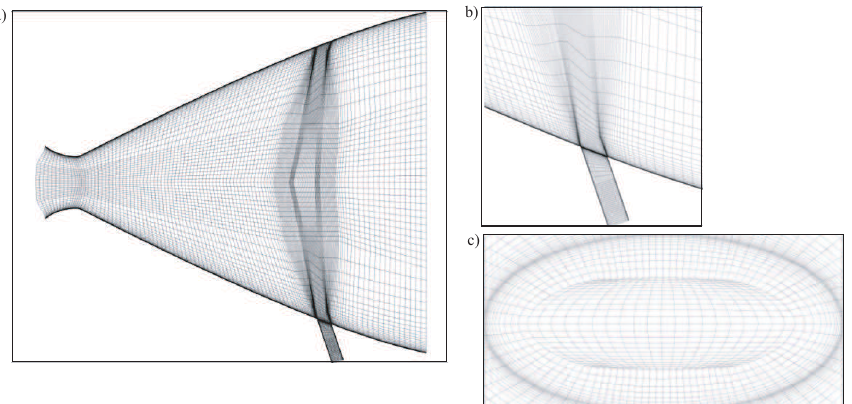
Figure 8. Computational mesh ( a ), mesh near injection port ( b ) and mesh in cross section of the injection port ( c ) with l j = 0.7, α j = 130 ◦ , d 2 / d 1 = 0.6, A ∗ / A a = 1.